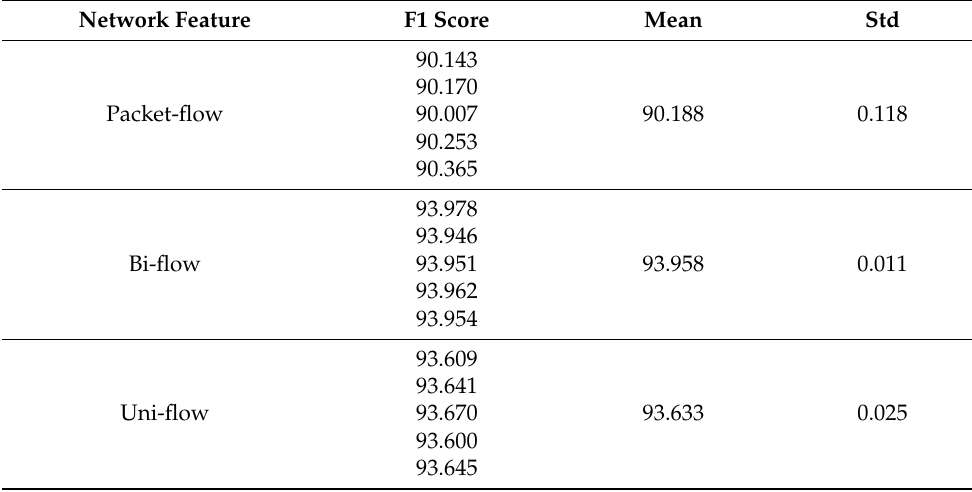
Table 13. Binary-class attack classification results in term of